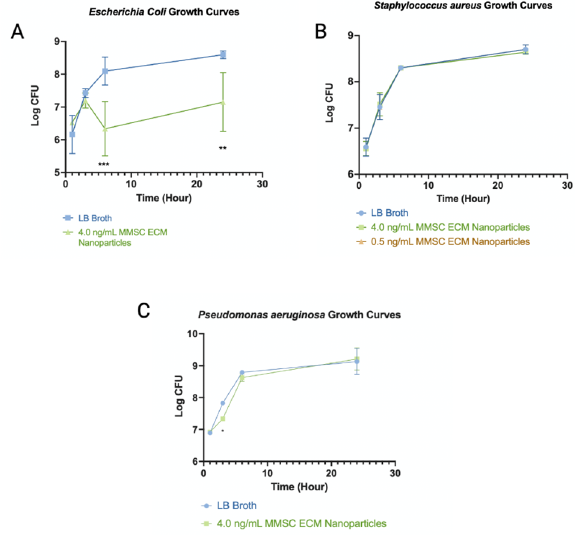
Figure 10. Bacterial assay growth curves. ( A ) Comparison of E. coli growth curves for LB Broth control culture and 4.0 ng/mL MMSC ECM nanoparticle culture. MMSC ECM nanoparticles show signi fi cant inhibition of growth at hours 6 and 24. ( B ) Comparison of S. aureus growth curves for LB broth control culture, 4.0 ng/mL MMSC ECM nanoparticle culture, and 0.5 ng/mL MMSC ECM nanoparticle culture. MMSC ECM nanoparticles did not inhibit the growth of S. aureus . ( C ) Comparison of P. aeruginosa growth curves for LB broth control culture and 4.0 ng/mL MMSC ECM nanoparticle culture. MMSC ECM nanoparticles show signi fi cant inhibition of P. aeruginosa growth at hour 3. The data displayed are the mean ± standard deviation. * indicates p < 0.05, ** indicates p < 0.001, *** indicates p < 0.0001. The concentration of 4.0 ng/mL MMSC ECM nanoparticles was found to be signi fi cantly di ff erent after 3 h of incubation. N = 3.